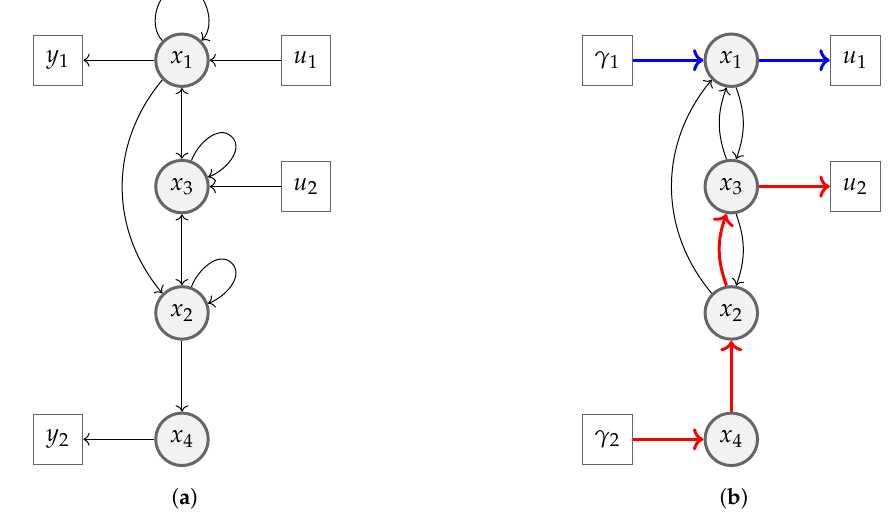
Figure 4. Digraph and explicit expressibility graph to study the differential flatness property. ( a ) Digraph for model and ; ( b ) Explicit expressibility graph. M 1 M 2